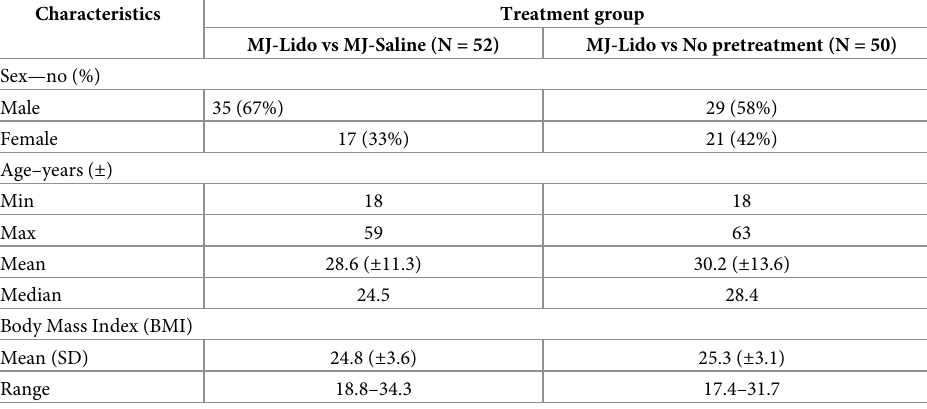
Table 1. Baseline demographic characteristics.